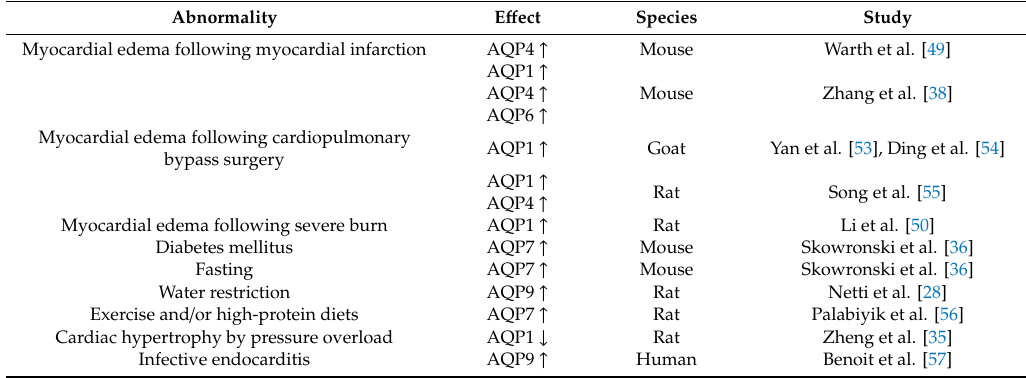
Table 2. E ff ect of various abnormalities on AQP expression in the